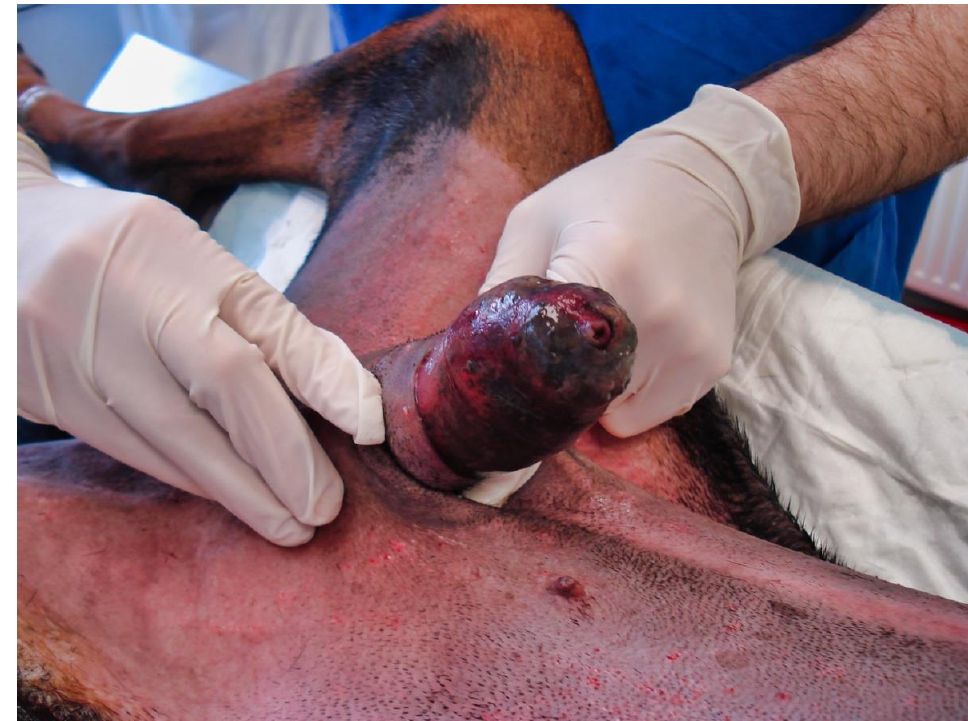
Figure 3. Extent of penile necrosis the day following admission.